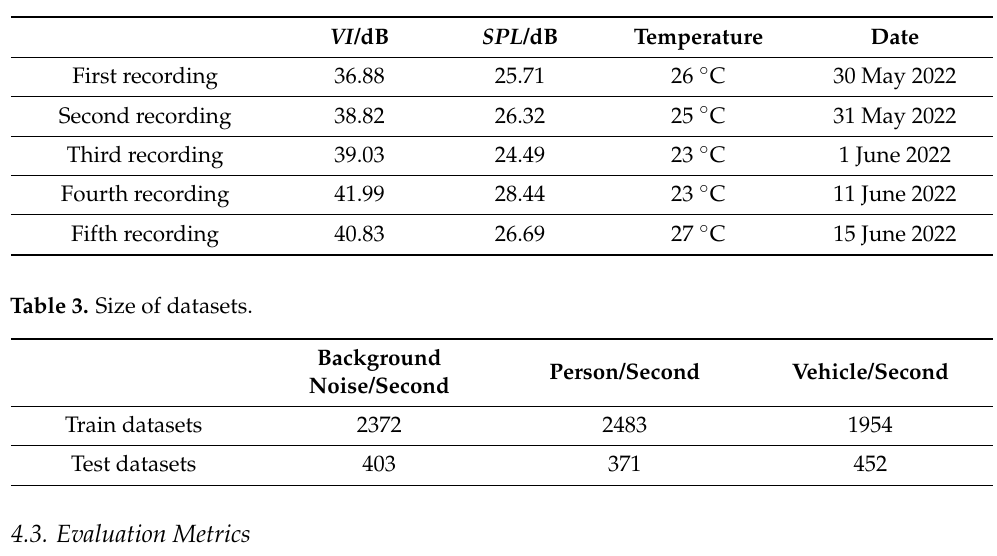
Table 2. Recording environments.